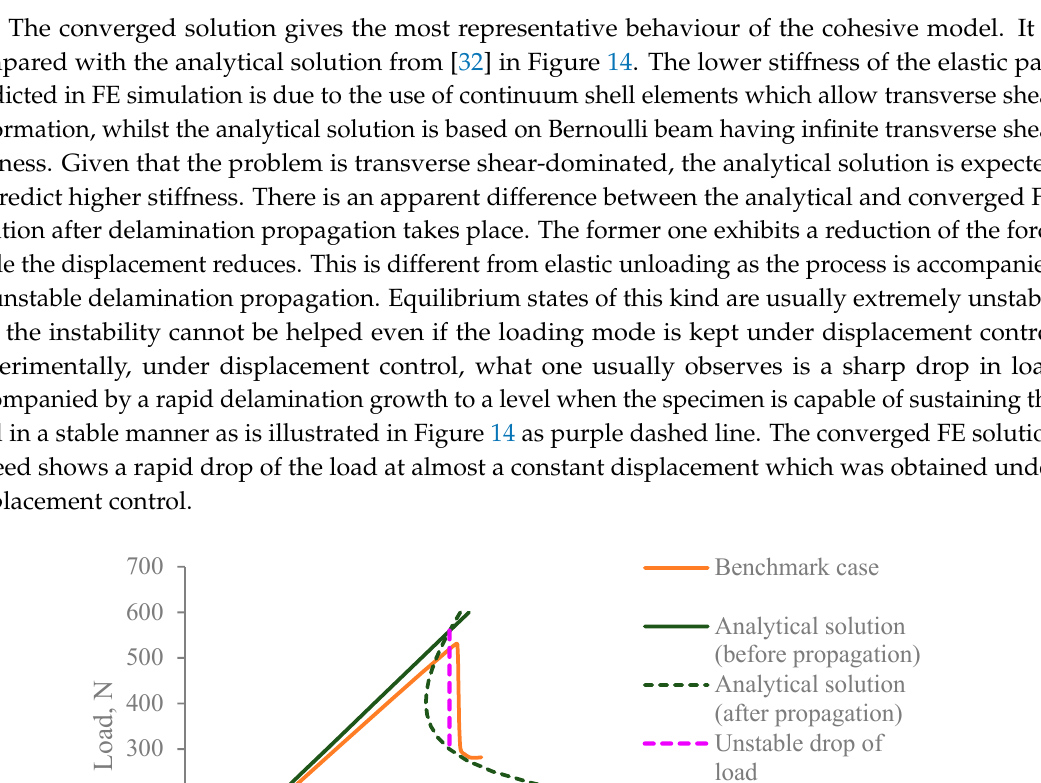
Figure 13. Influence of viscosity on load-displacement predictions obtained with Mode II model.